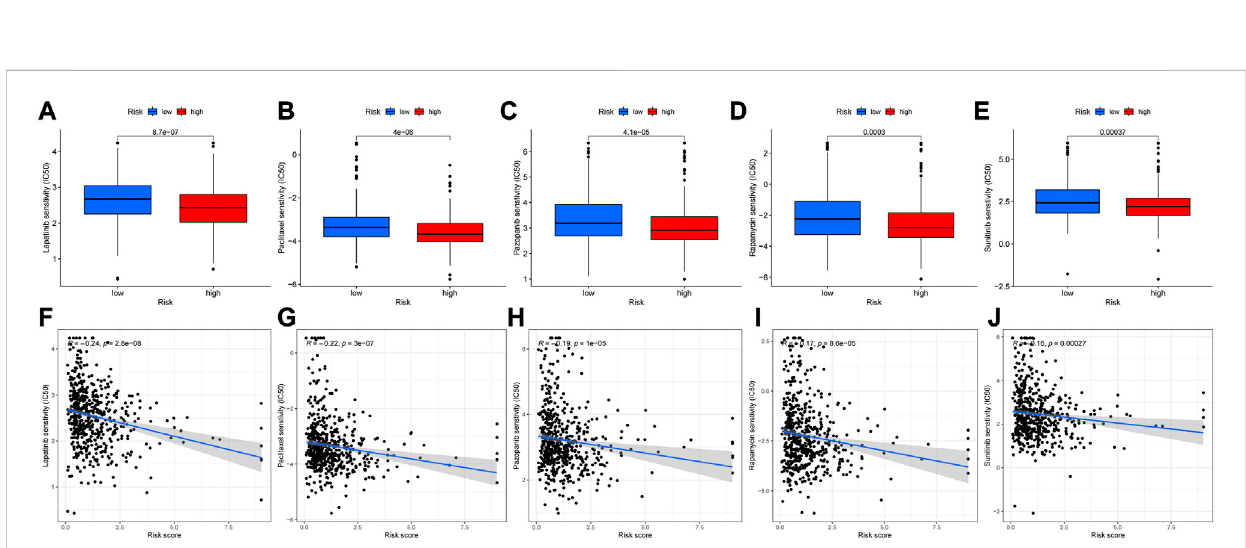
FIGURE 12 Drugsensitivityanalysis. (A – E) Ic50(thehalfmaximalinhibitoryconcentration)valuesofdifferentdrugs(Lapatinib,Paclitaxel,Pazopanib,Rapamycin, Sunitinib) in the high-risk and low-risk groups. (F – J) Correlation between drug sensitivity and value at